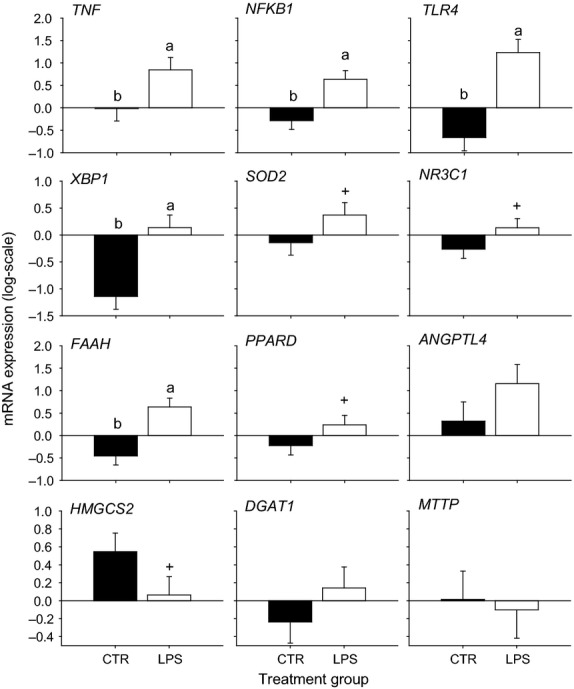
The effect of intra-mammary LPS or saline (CTR) challenge at 7 days postpartum in Holstein cows on mRNA expression of pro-inflammatory (TNF, NFKB1, TLR4), intracellular stress (XBP1, SOD2, NR3C1), PPAR signaling (FAAH, PPARD, ANGPTL4), and lipid metabolism (HMGCS2, DGAT1, MTTP) in liver tissue 2.5 h after intra-mammary LPS challenge. a–bDenote differences due to LPS challenge. +Denote tendencies (P < 0.10) for differences due to LPS challenge.